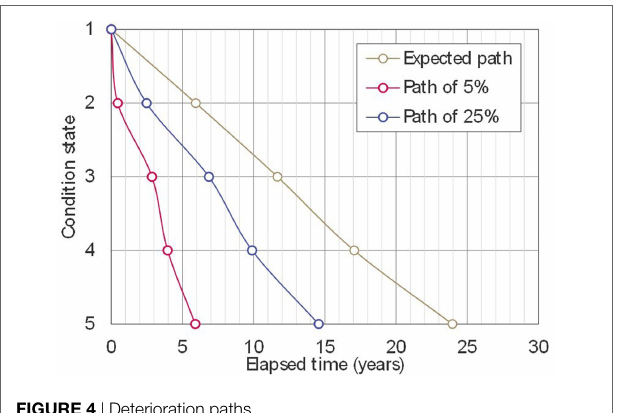
FIGURE 4 | Deterioration paths.